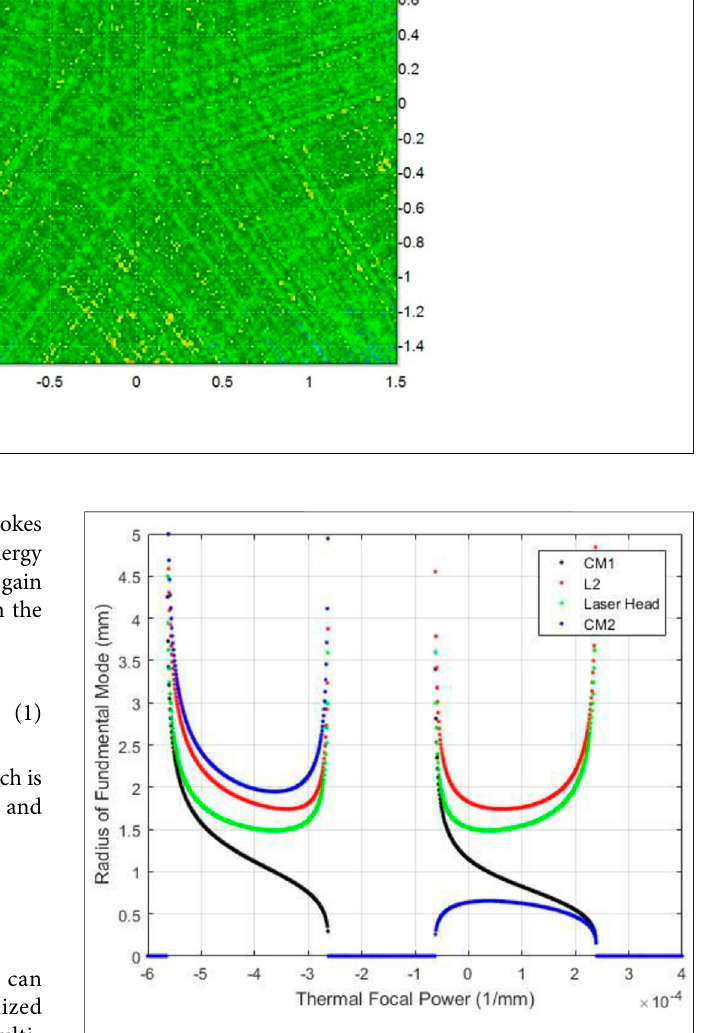
FIGURE 6 | Optimized stability zones of the regenerative